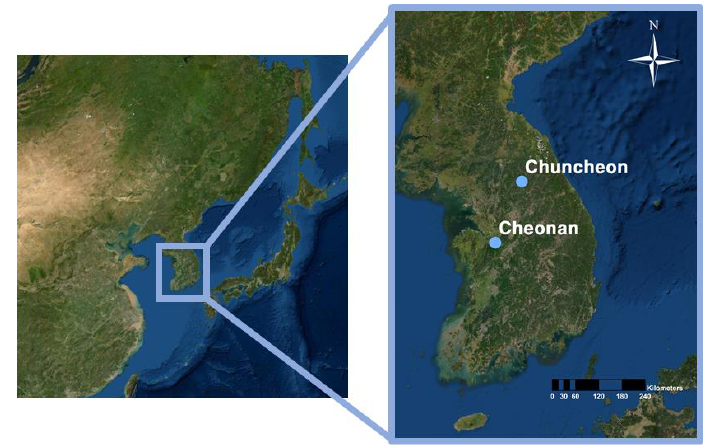
Figure 1. Location of meteorological sites.